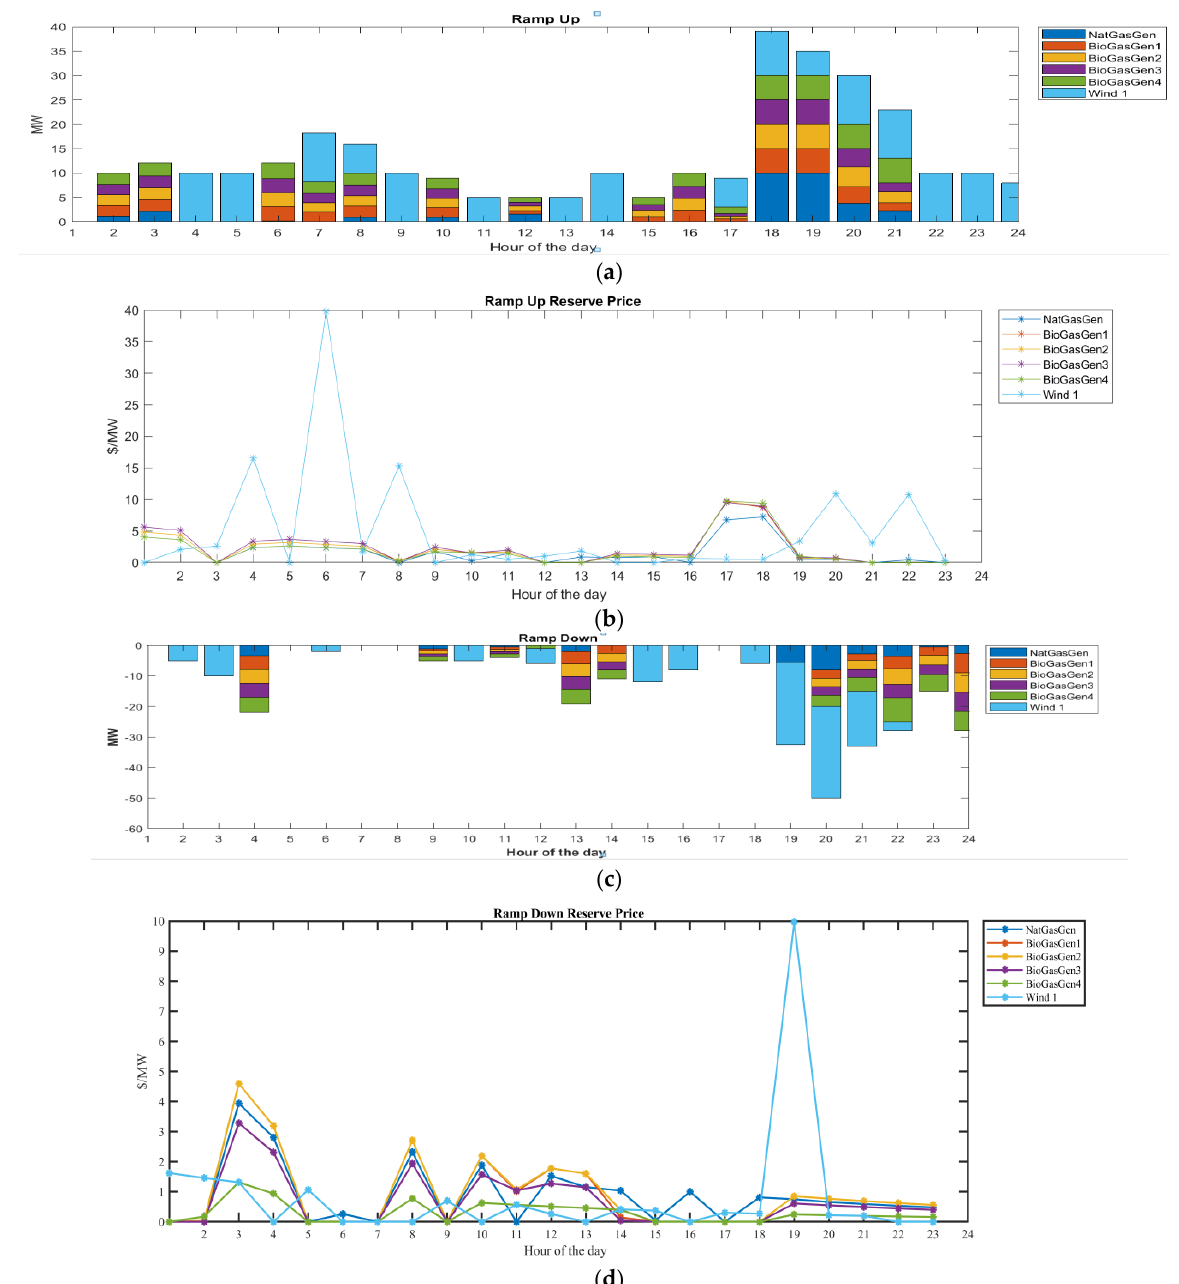
Figure 13. ( a ) Ramp-up reserves offered during load-following, ( b ) Ramp-up reserve price, ( c ) Ramp-down reserves offered during load-following by each resource, and ( d ) ramp-down reserve price.